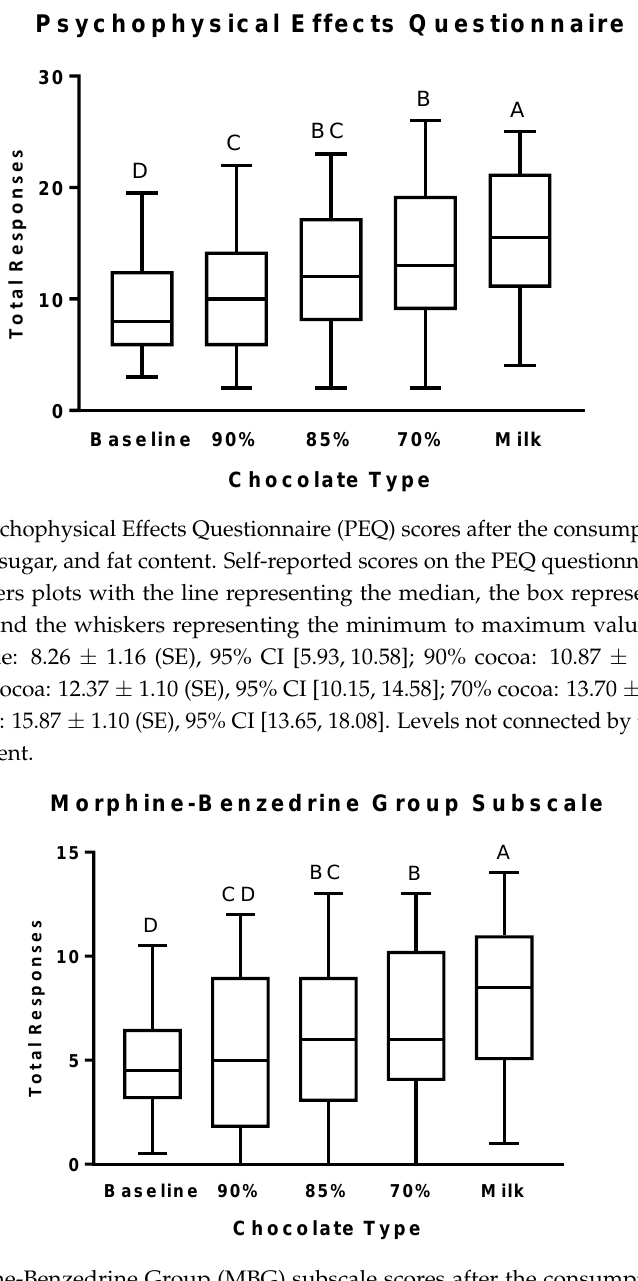
Figure 2. Morphine-Benzedrine Group (MBG) subscale scores after the consumption of chocolates differing in cocoa, sugar, and fat content. Self-reported scores on the MBG subscale are presented as box and whiskers plots with the line representing the median, the box representing the 25th to 75th percentiles, and the whiskers representing the minimum to maximum values. Least-squares means are Baseline: 4.28 ± 0.71 (SE), 95% CI [2.86, 5.69]; 90% cocoa: 5.37 ± 0.66 (SE), 95% CI [4.03, 6.70]; 85%